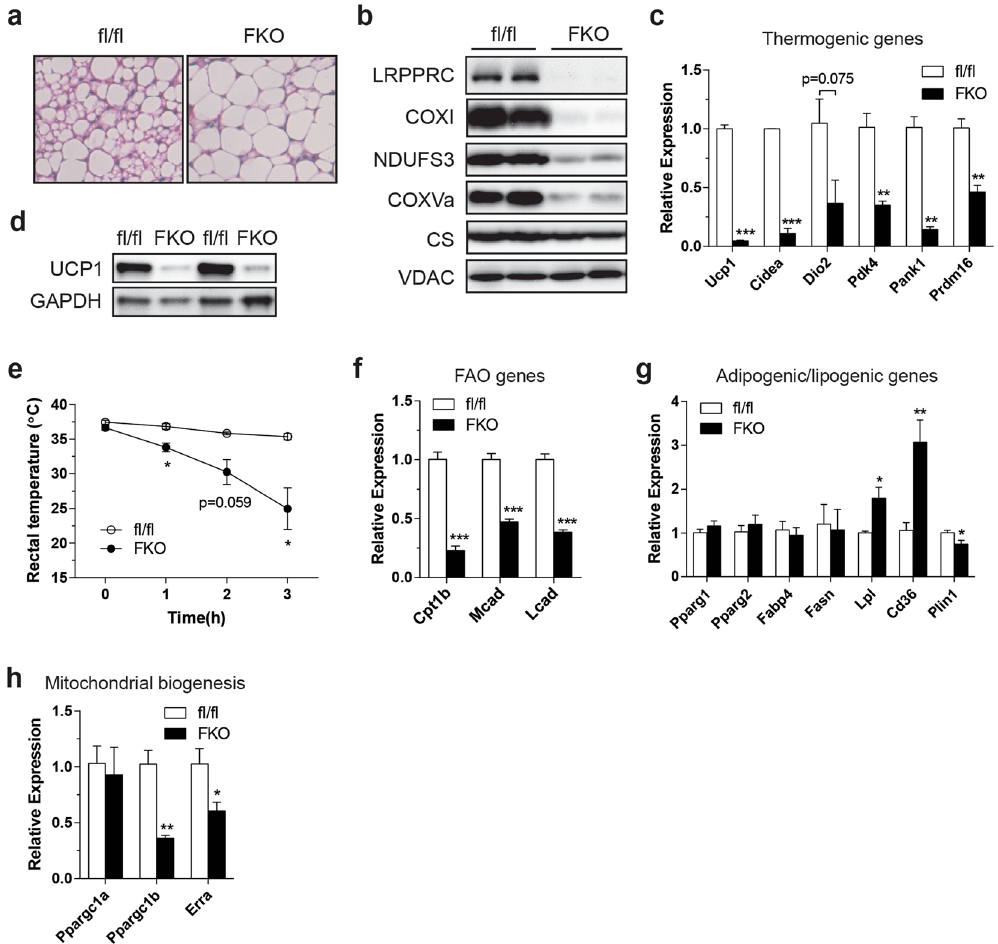
Figure 2. Impaired respiratory capacity attenuates thermogenic and oxidative gene expression in BAT from LRPPRC FKO mice living at 30 °C. ( a ) H&E staining of BAT. ( b ) Immunoblot of LRPPRC, COXI, NDUFS3, COXVa, CS and VDAC in BAT. ( c ) mRNA levels of thermogenic genes in BAT. ( d ) Immunoblot of UCP1 and GAPDH (loading control) in BAT. ( e ) Core temperature of control and LRPPRC FKO mice during acute cold exposure at 4 °C. ( f–h ) mRNA levels of FAO genes ( f ), adipogenic/lipogenic genes ( g ) and mitochondrial biogenesis genes ( h ) in BAT. 12–14 week-old male were used, n = 3–4. Data are mean ± SEM. * P < 0.05, ** P < 0.01, *** P < 0.001, two-tailed unpaired Student’s t- test ( c , e – h